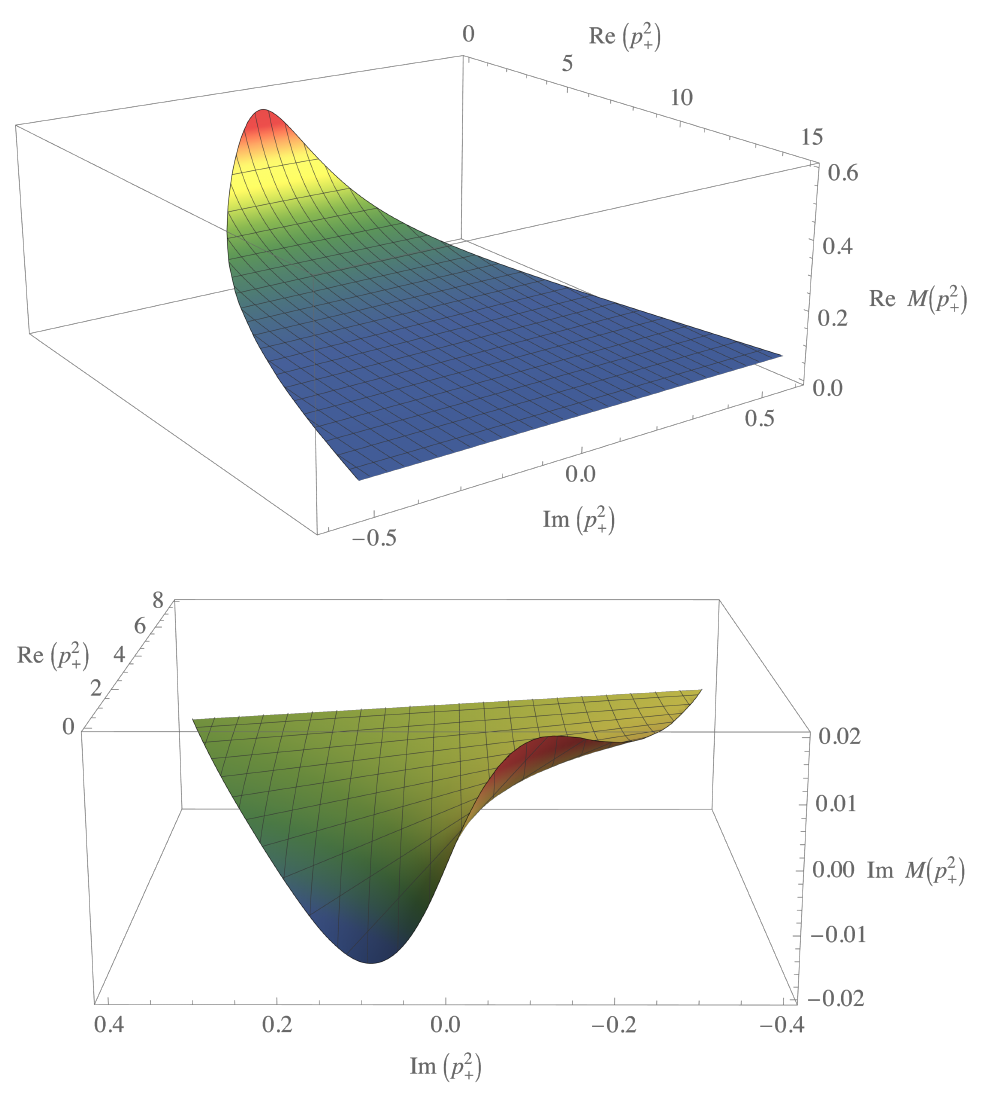
Figure 7 . Real part (upper panel) and imaginary part (lower panel) of the complex mass function M ( p 2 ) . The DSE is solved on the complex parabola with p + defined by eq. (4.8), the external mass P 2 = − M 2 ( M π = 140 MeV) and η = 1 / 2 . We use the gluon and ghost propagators of π